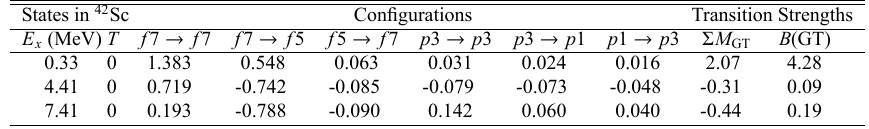
Table 1. The matrix elements M GT for the configurations contributing to the GT transitions exciting T = 0, J π = 1 + low-lying states in 42 Sc from the 0 + g.s. of 42 Ca. The pf -shell SM calculation was performed [23] using the GXPF1J interaction [27]. The notation π f 7 / 2 type. The summed value of the matrix elements is denoted by f 7 f 7, for example, stands for the transition with the ν f 7 / 2 → → Σ M GT and its squared value is the B (GT), where the B (GT) values do not include the quenching factor of the SM calculation.